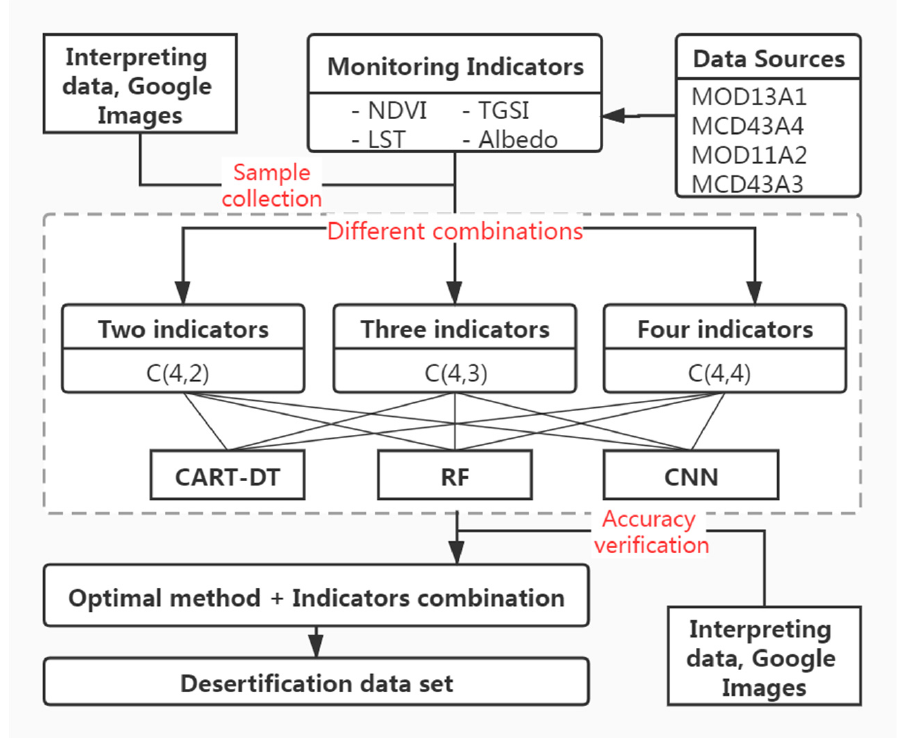
Figure 4. Flow chart illustrating the data sources and methodology used in this study. CART-DT, RF, and CNN are different machine learning methods. MOD13A1, MCD43A4, MOD11A2 and MCD43A4 are different MODIS datasets.